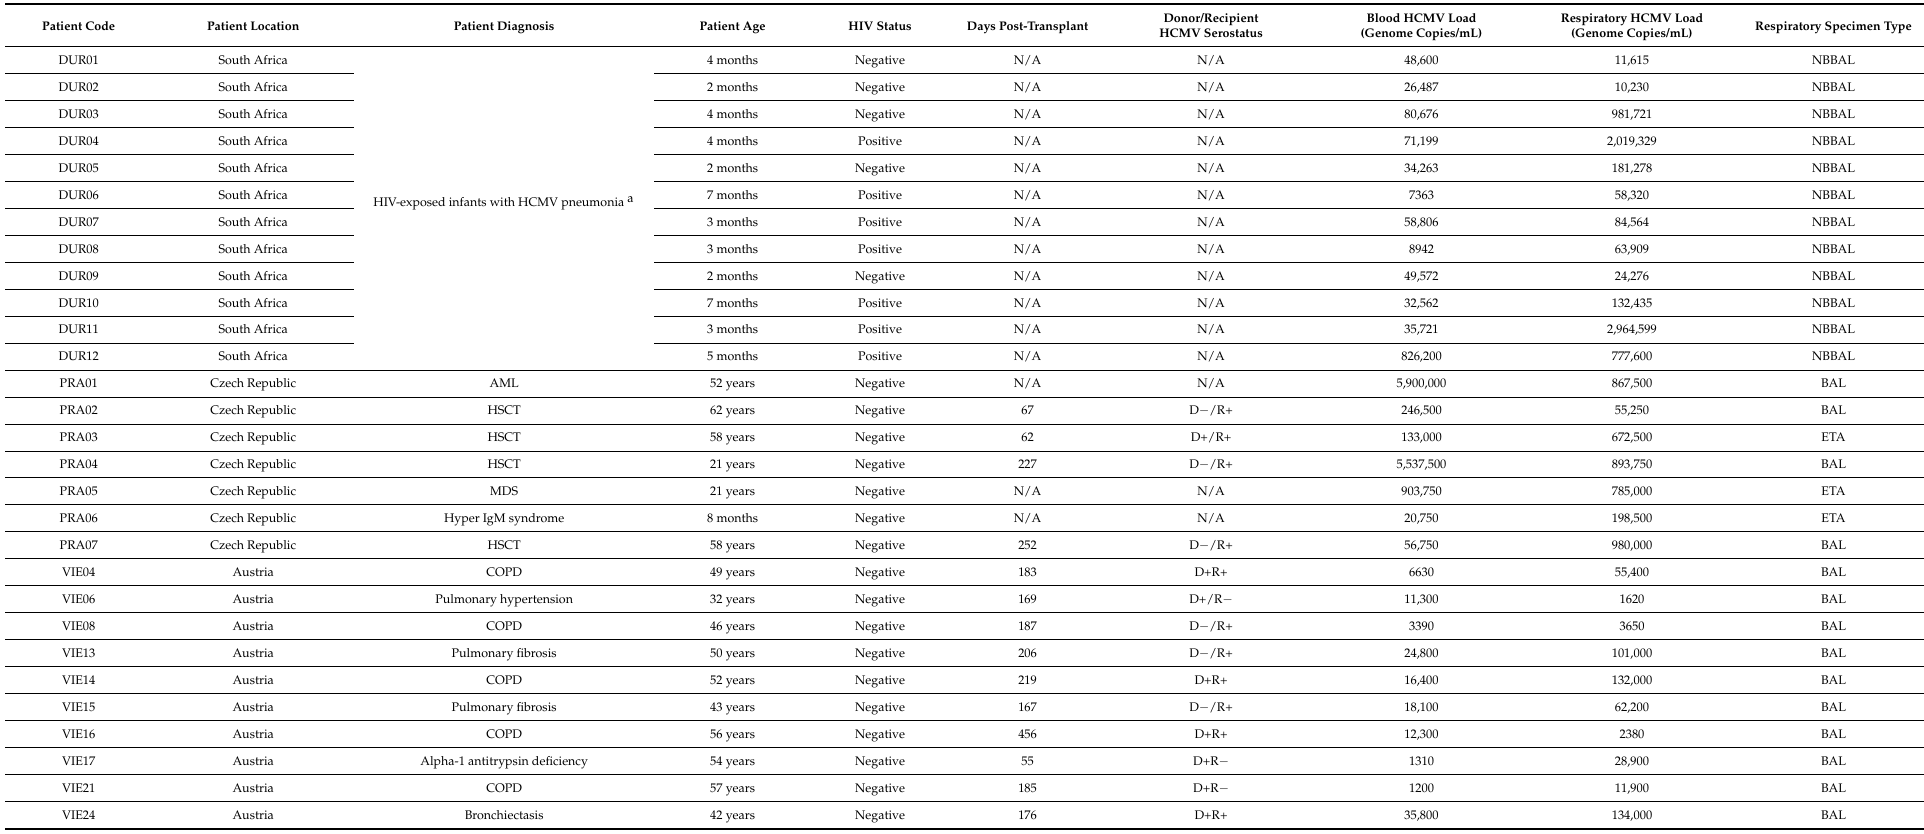
Table 1. Patient